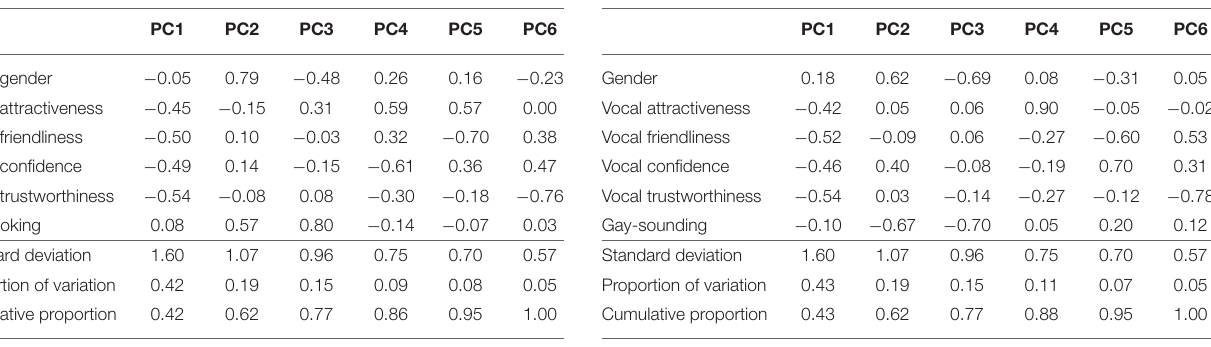
TABLE 5 | The cumulative proportion of variance accounted for and loadings from the PCA of the visual impression ratings.